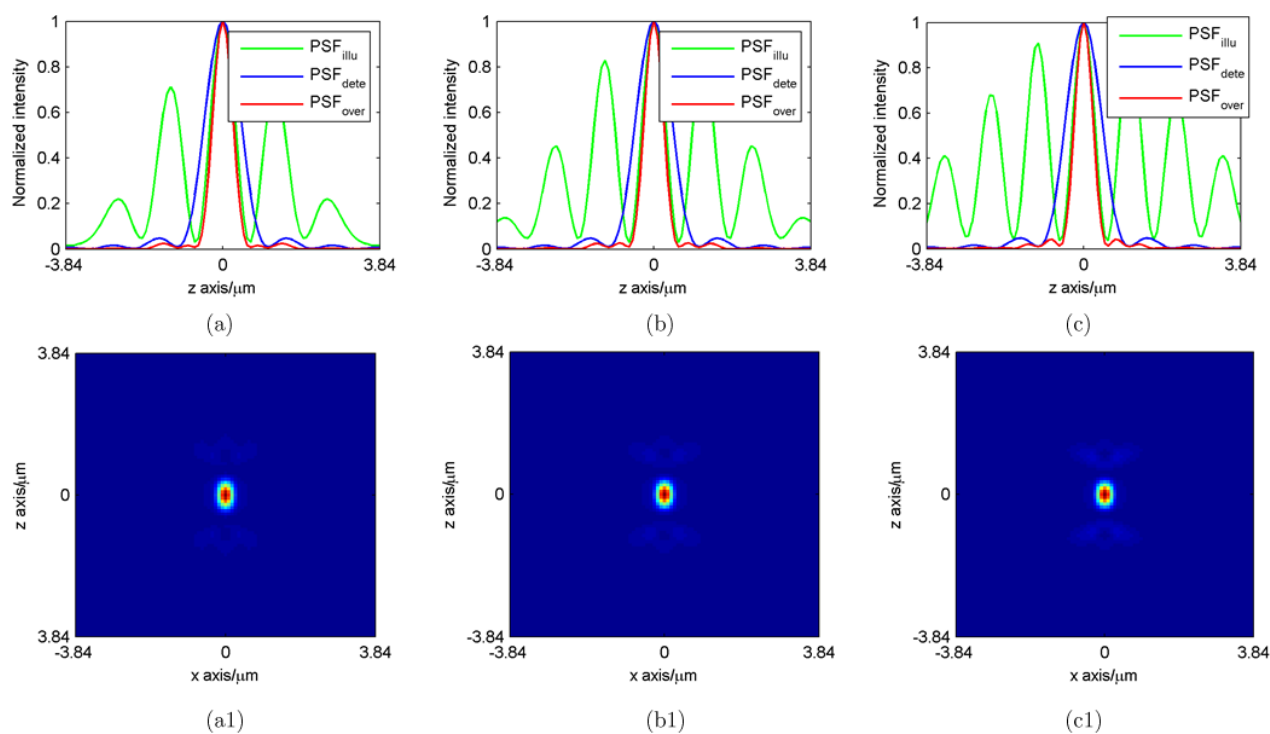
Fig. 4. (a), (b) and (c) The illumination, detection and overall point spread functions for the d / r factors of 1, 1.2 and 1.4 along z axis and (a1), (b1) and (c1) The overall point spread functions for d / r factors of 1, 1.2 and 1.6 in zx